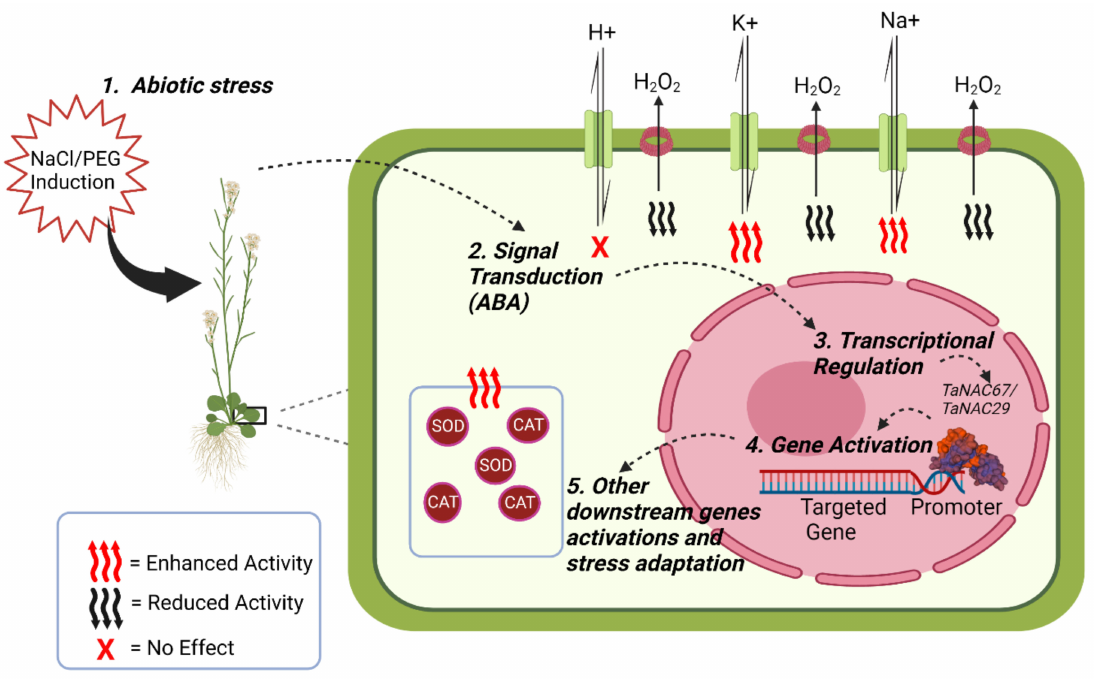
Figure 4. An overview of the regulation of abiotic stress by TaNAC67 and TaNAC29 in transgenic Arabidopsis. (1) Transgenic Arabidopsis overexpressing TaNAC67 and TaNAC29 acquired tolerance to abiotic stress after NaCl and PEG treatment, respectively. (2) NaCl and PEG-induced abiotic stress tolerance leads to transduction of the ABA signal (3 and 4). Transduction of the ABA signal leads to transcriptional regulation by TaNACs to activate their targeted genes. (5) As a consequence of targeted gene activation, some other downstream genes are activated and lead to general stress man- agement. Transgenics overexpressing TaNAC29 accumulated less H 2 O 2 and showed increased CAT and SOD enzyme activities that made transgenics salt and drought tolerant. Similarly, transgenics overexpressing TaNAC67 had higher efflux rates of K+ and Na+ ions, and no significant effect on the H + ion flux rate allowed transgenics to be more